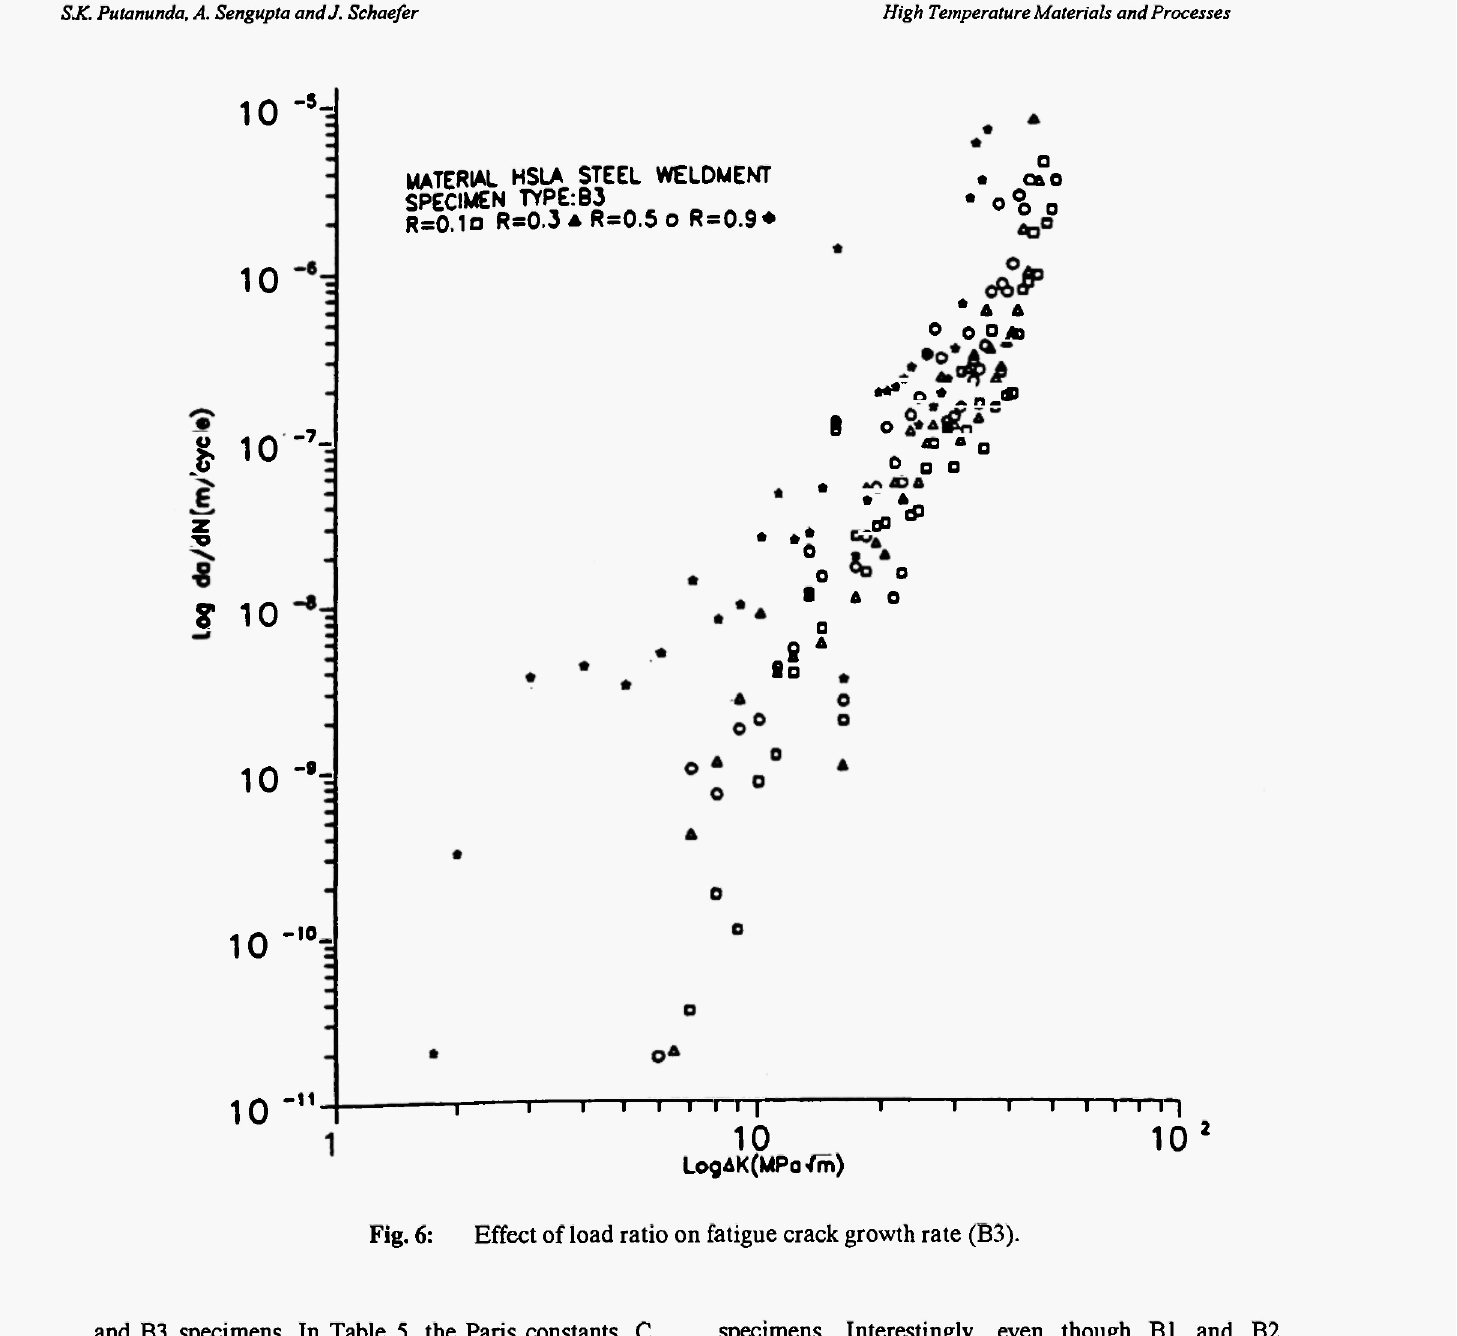
Fig. 6: Effect of load ratio on fatigue crack growth rate